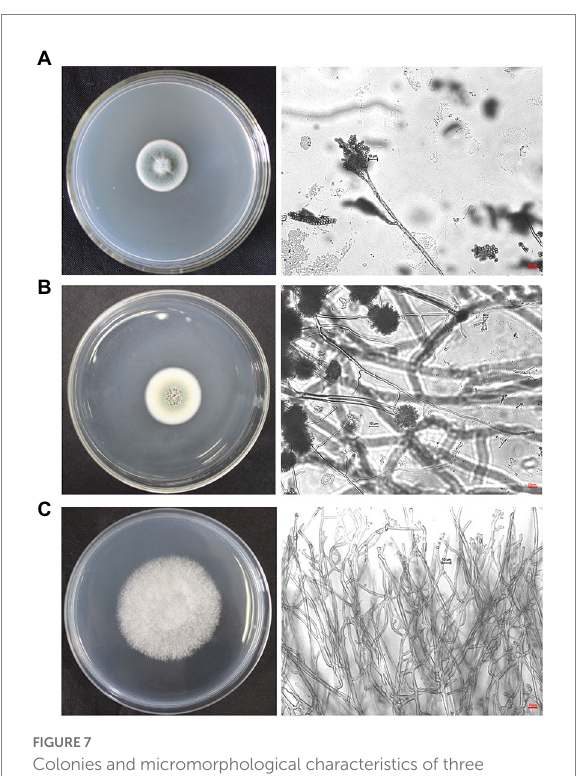
FIGURE 7 Colonies and micromorphological characteristics of three dominant fungi isolated from September 2020 samples (×400). The scale bars of the microphotographs were 10 μ m. (A) Penicillium. (B) Aspergillus . (C) Cerrena